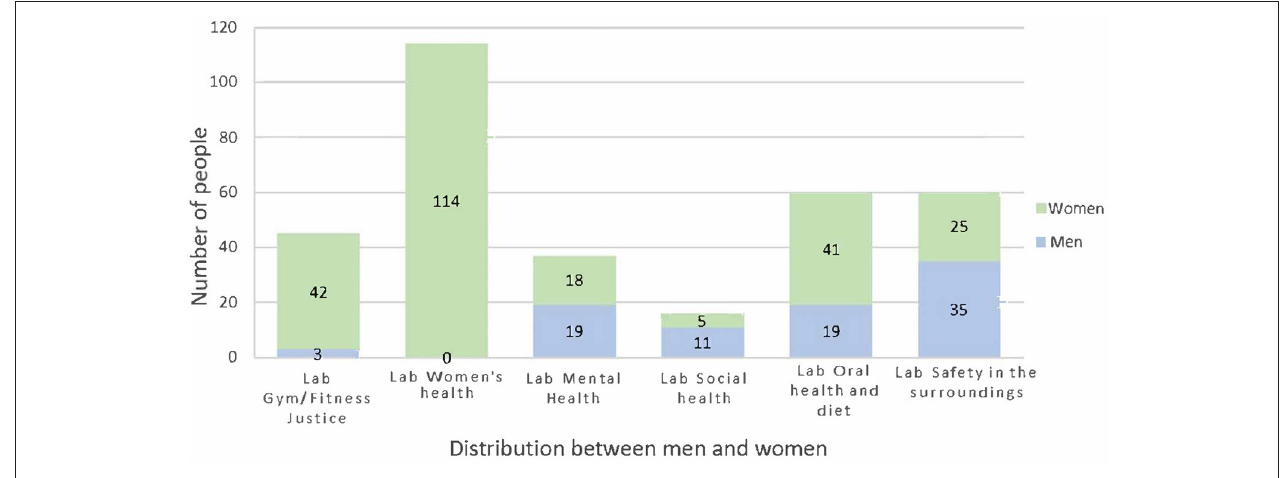
FIGURE 1 | Participants by gender and lab.